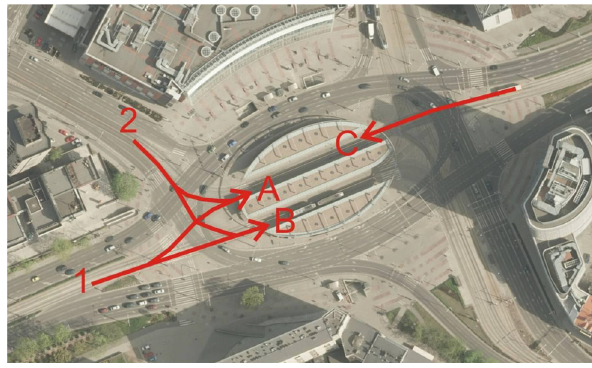
Figure 3: Routes of entering trams to the platforms and localization of level crossings ( A, B, and C ) .